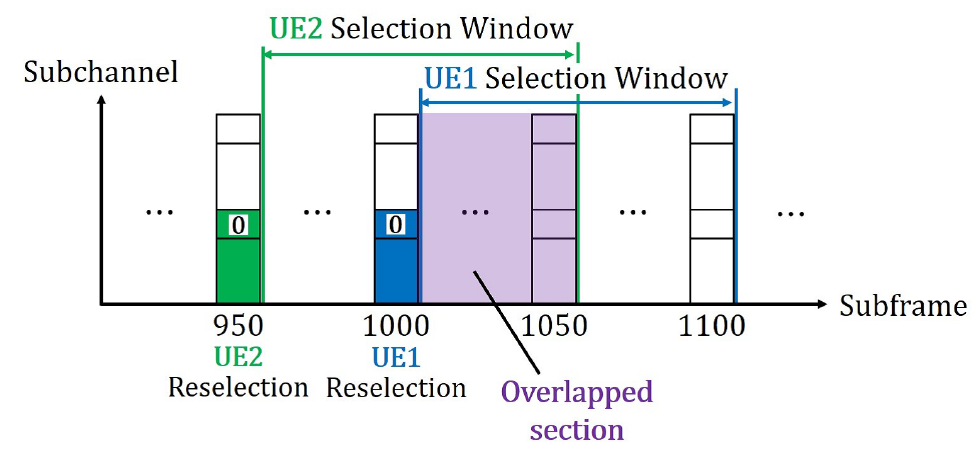
Figure 7. Example of overlapping selection